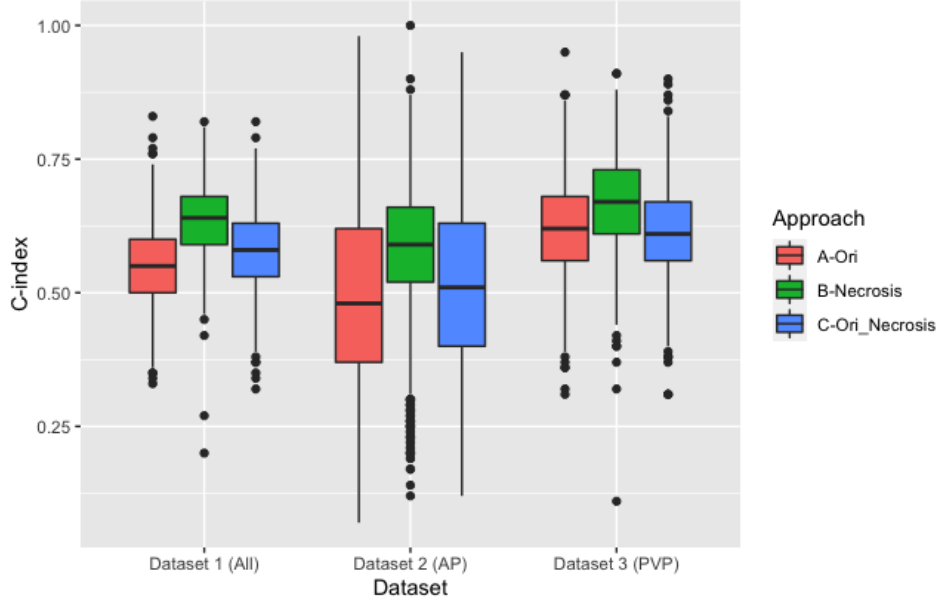
Figure 2. Boxplot comparison of the C-indices of the clinical and original RF models. In Dataset 2, the c index values across the 1000 repeats ranged between 0.07 and 0.98, with an average ( ± SD) of 0.50 ± 0.18. None of the features was selected more than 50% of the times. Intensity minimum and intensity kurtosis were the most selected features (49.5 % and 46%,